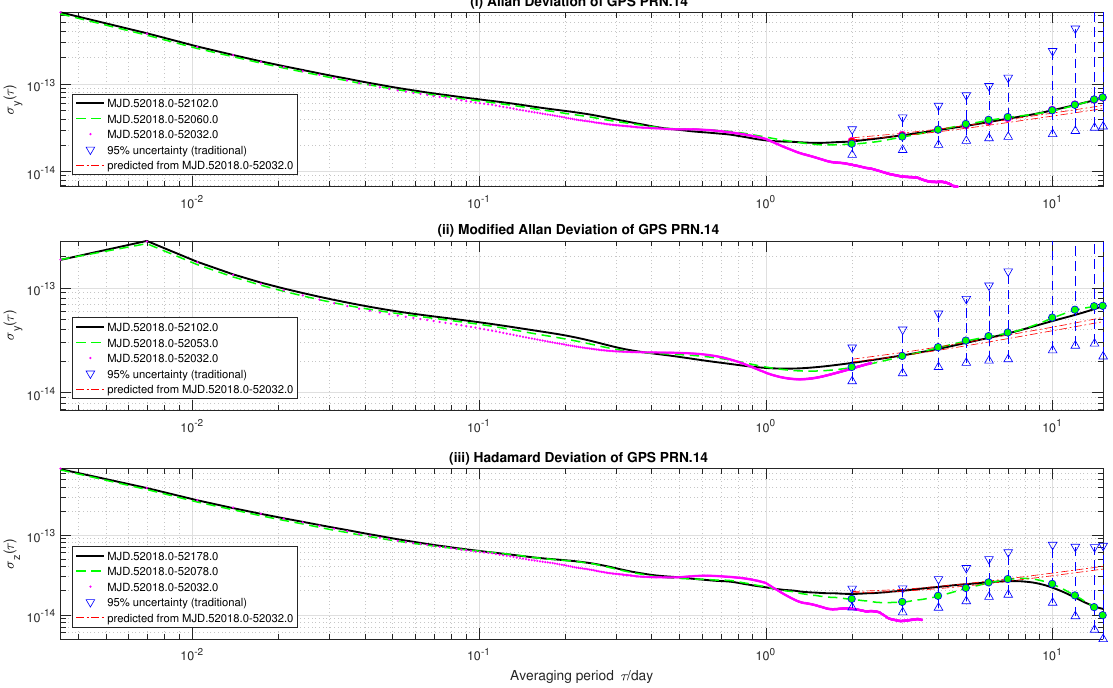
Figure 2. Estimates and prediction of GPS SVN.41 (PRN.14) rubidium clock frequency